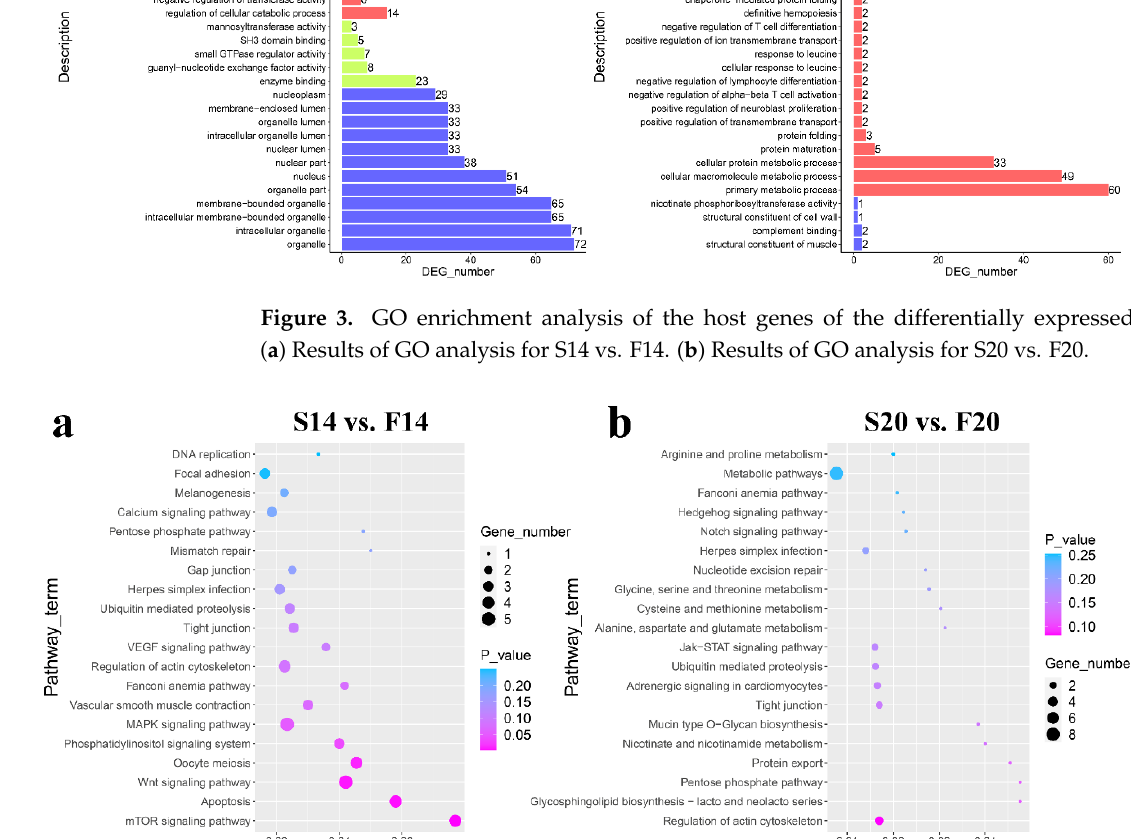
Figure 3. GO enrichment analysis of the host genes of the differentially expressed circRNAs. ( a )